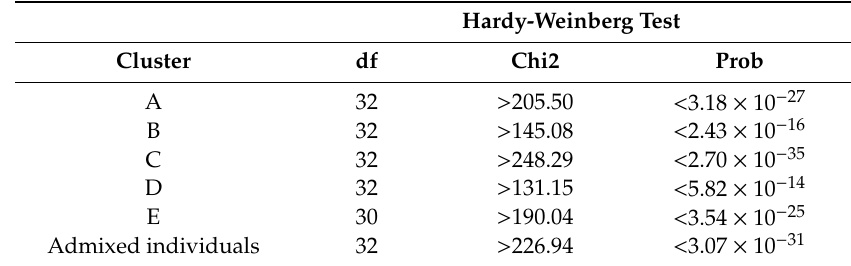
Table 2. Hardy–Weinberg Exact test (Fisher’s method) based on the STRUCTURE clusters of Emys trinacris .